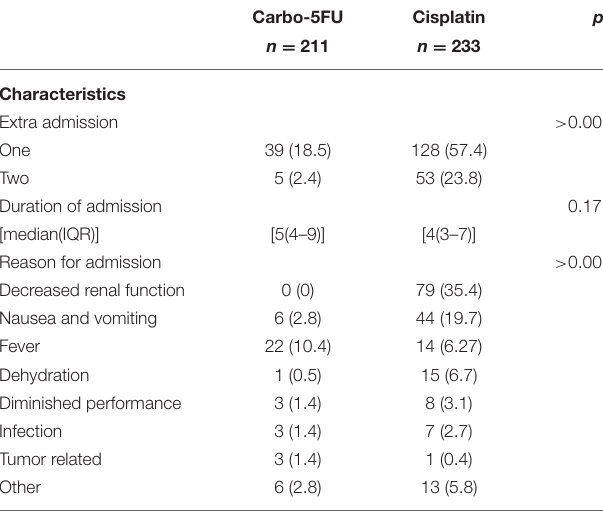
TABLE 6 | Reasons Extra Hospital